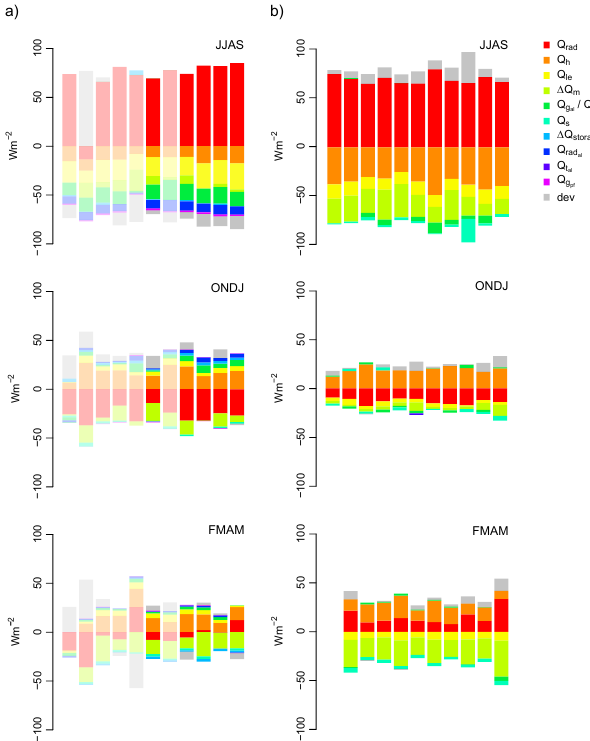
Figure 3. Seasonal energy balance components at the Murtèl– 38 Corvatsch rock glacier. (a) shows the observations and (b) shows the modeled components. Faded colors indicate years with incom- plete measurements. Q rad : net radiation; Q h : sensible heat flux at the surface; Q le : latent heat flux at the surface; ∆ Q m : melt energy in the / Q g : snow cover; Q s : conductive heat flux through the snow; Q g al conductive heat flux within the active layer (a) / through the sur- face (b) ; Q rad : net radiation in the active layer; ∆ Q storage : change in al heat content in the active layer; Q t : turbulent heat flux in the ac- al tive layer; Q g : conductive heat flux through the permafrost table; pf dev: energy balance closure. The seasons are divided into: June– September (JJAS), October–January (ONDJ) and February–May